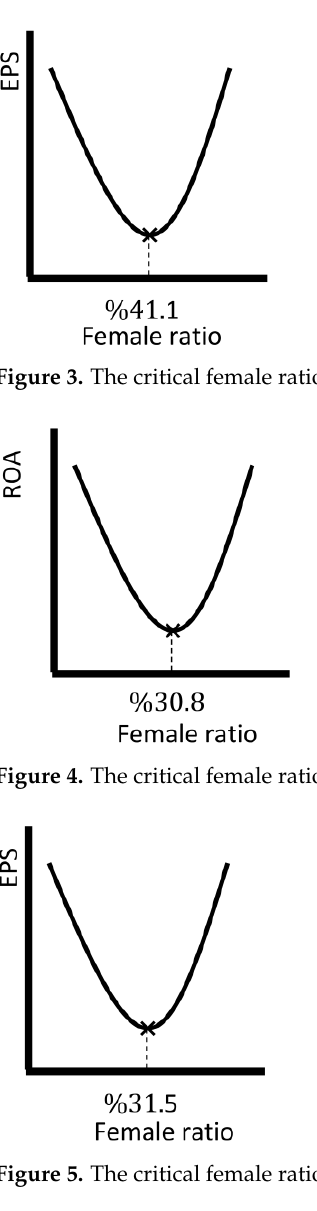
Figure 6. The quartile impact of female ratio on ROA. As mentioned previously, the main contributions of this study are three-fold. Firstly, to test the impact of female representation in PEX bord of directors, the investigations include the linear and the existence of the critical mass relationship. Secondly, to deter- mine the impact of firms’ internal characteristics including holding PhD’s, firms’ size, growth, and age; besides, including governance indicators namely duality on gender di- versity in PEX. Thirdly, to test at which level of output the impact of gender diversity on firms’ performance is more effective. This could be tested by conducting the quantile re- gression.